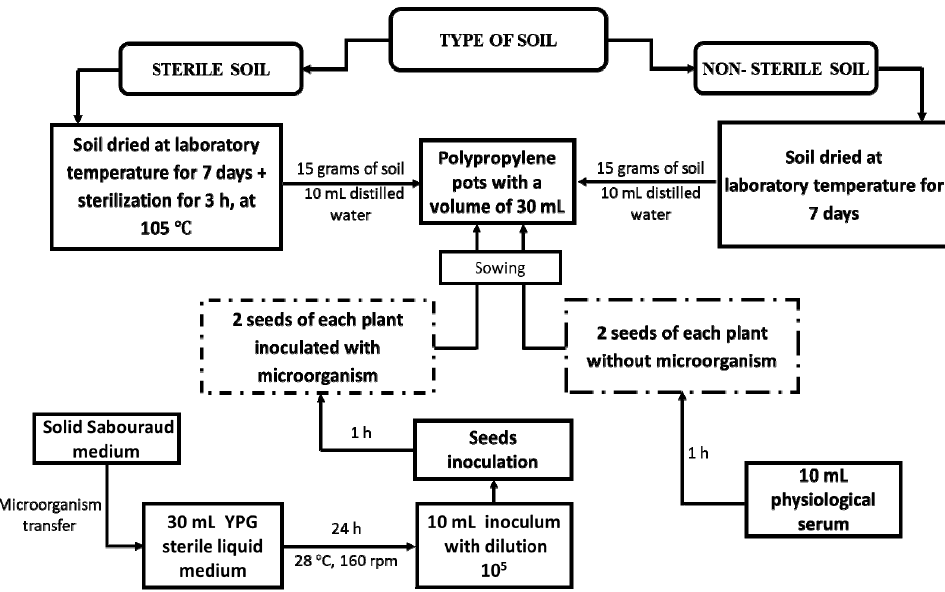
Figure 2. Experimental protocol for screening of Azotobacter , Bacillus and Pseudomonas species as PGPB. as